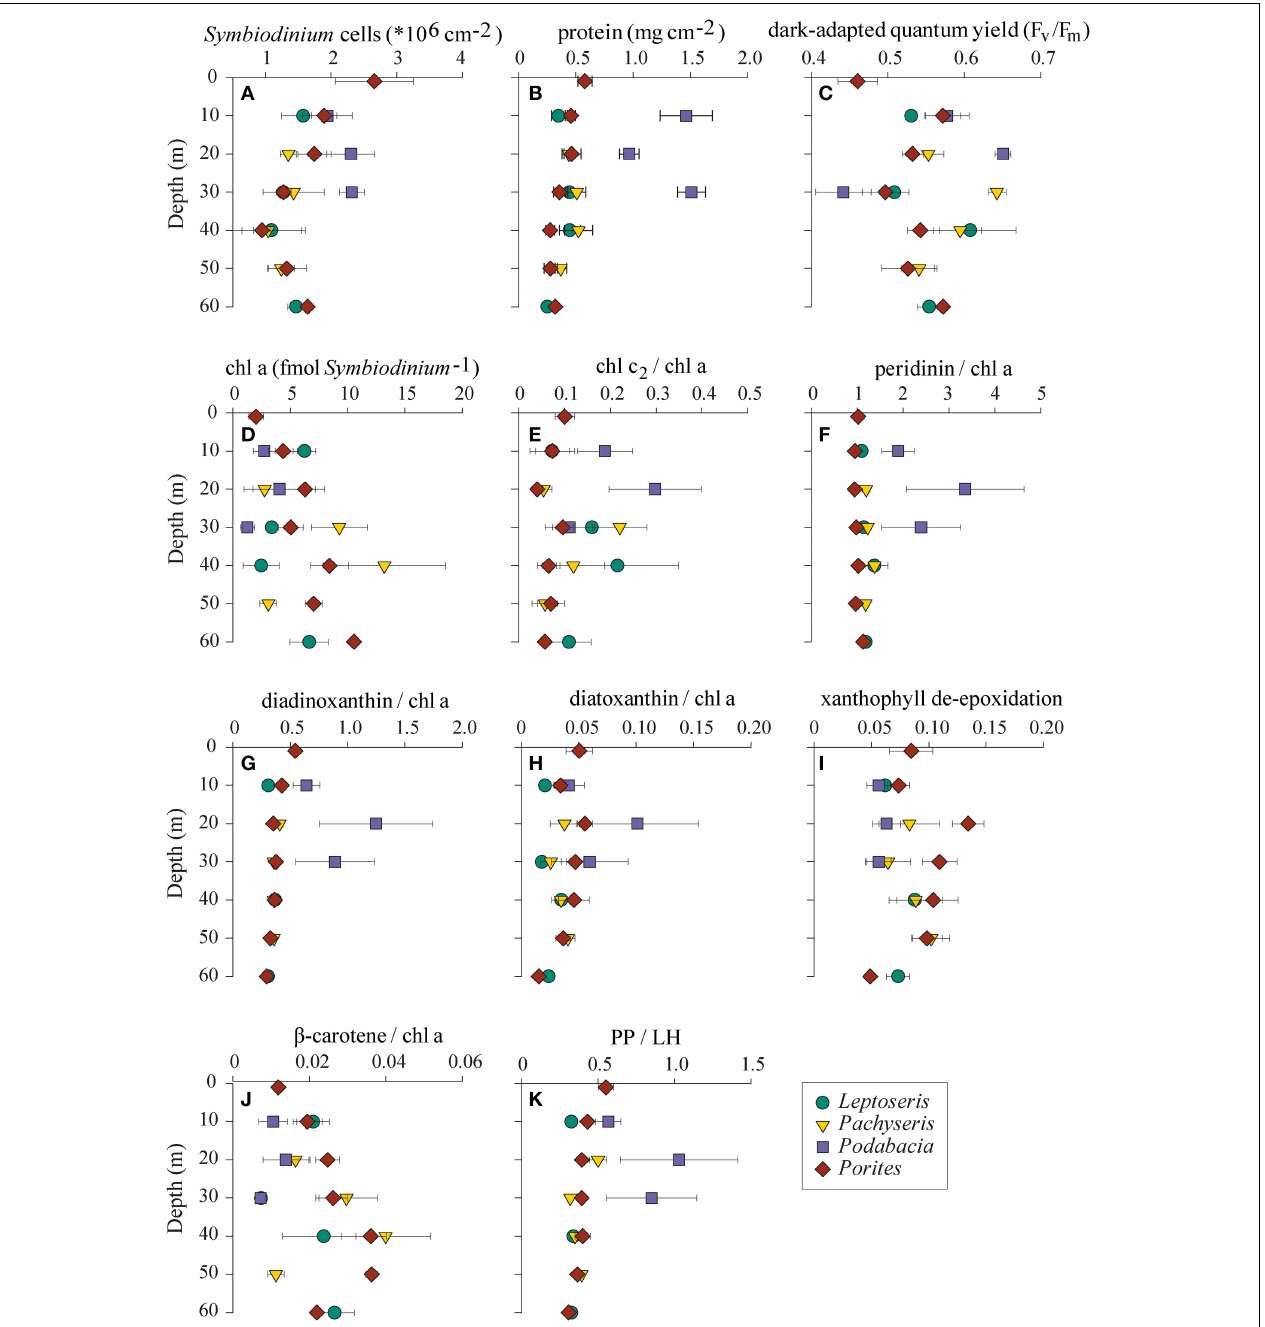
FIGURE 4 | (A–K) Physiological parameters of four coral genera collected in the central Saudi Arabian Red Sea along a 60m depth gradient (means ± SE) in November 2012. Symbol shapes and colors represent coral hosts: